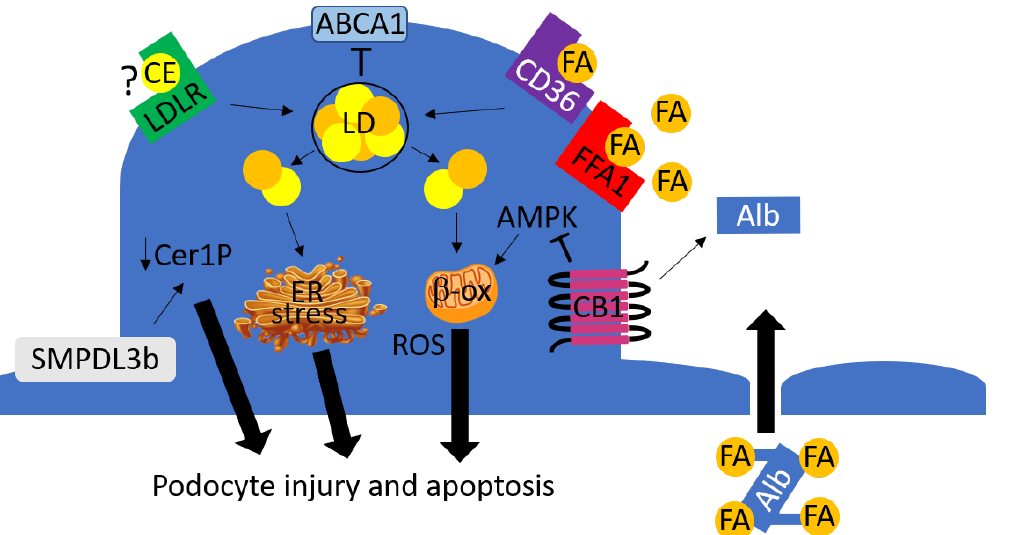
Figure 1. Lipotoxicity in the podocyte. Under pathologic (albuminuric) circumstances, fatty acids and cholesterol esters are taken up by separate mechanisms. If the accumulated lipids exceed storage capacity within lipid droplets, toxic metabolites accumulate and lead to reactive oxygen species generation, endoplasmic reticulum stress, and ultimately podocyte cell death. Abbreviations: albumin (Alb), AMP-activated protein kinase (AMPK), ATP-binding cassette A1 (ABCA1), cannabinoid receptor type 1 (CB1), ceramide-1-phosphate (Cer1P), cholesterol ester (CE), endoplasmic reticulum (ER), fatty acid (FA), free fatty acid receptor-1 (FFA1), lipid droplet (LD), low density lipoprotein receptor (LDLR), reactive oxygen species (ROS), acid sphingomyelinase-like phosphodiesterase 3b